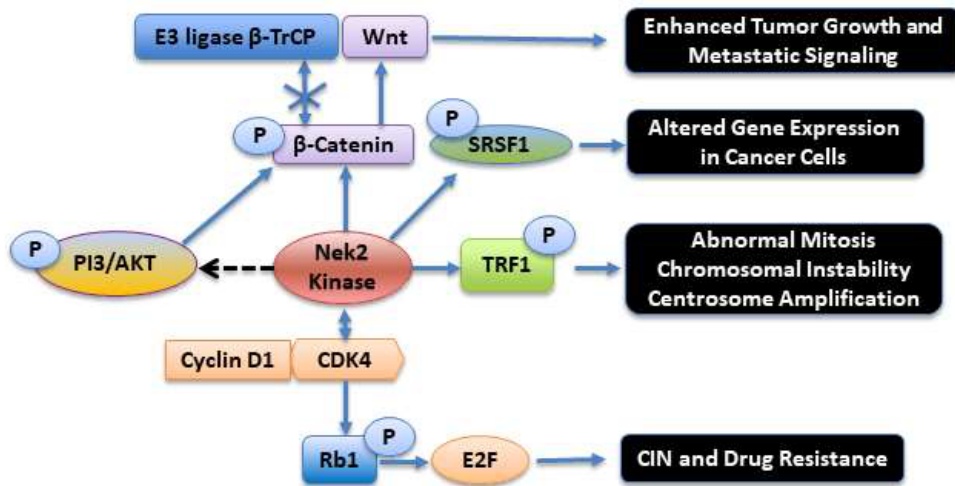
Figure 4. Aberrant Nek2 function promotes several key oncogenic signaling pathways.